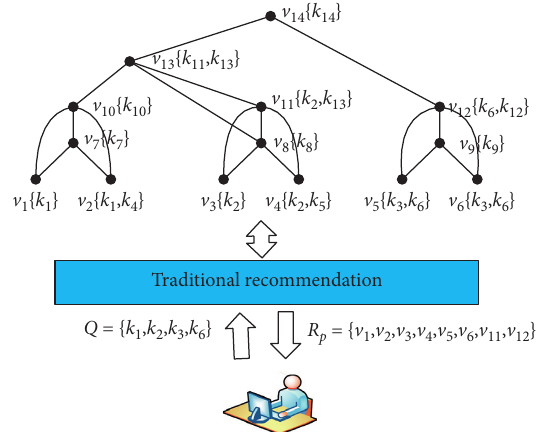
Figure 3: An example of the traditional paper recommendation